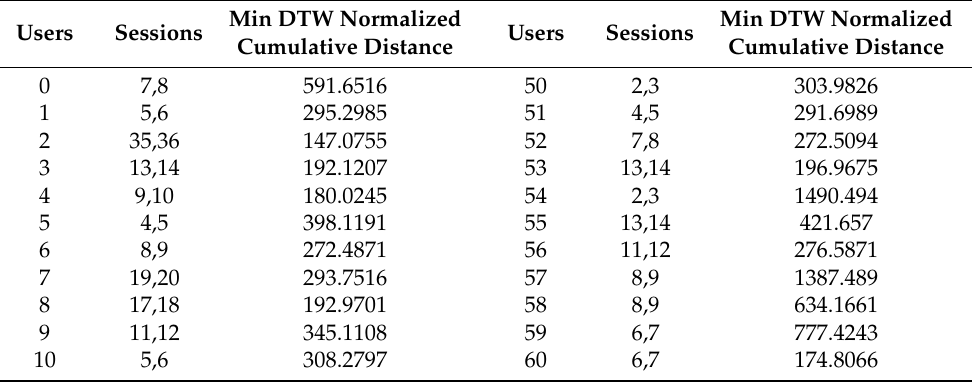
Table 2. The most similar trajectories generated by each participating user in the ReMouse dataset with their respective DTW values—the minimum DTW normalized cumulative distance between the closest